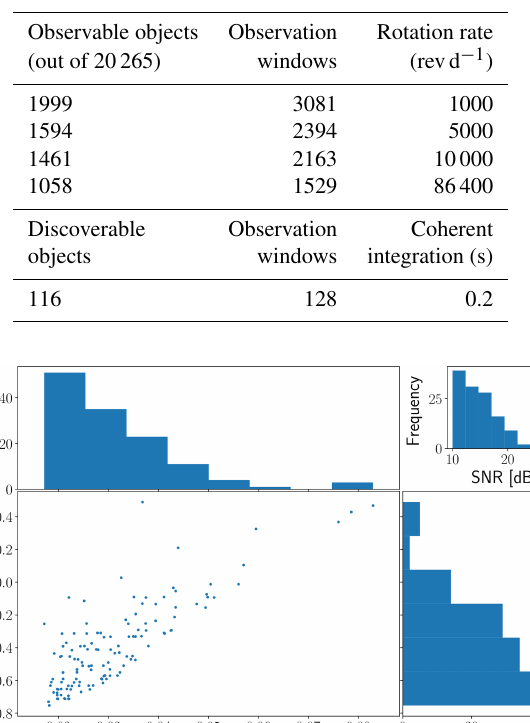
Figure 11. The length of each possible observation window that would provide a SNR above 10dB assuming a rotation rate of 1000 revolutions per day and that a prior orbit is available.